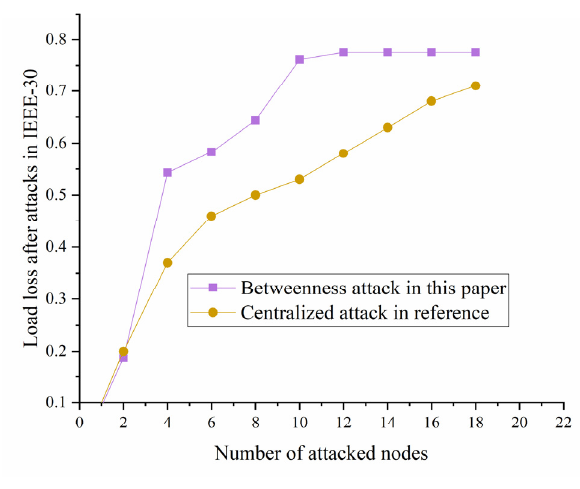
Figure 27. Comparation of the vulnerability with literature [62].